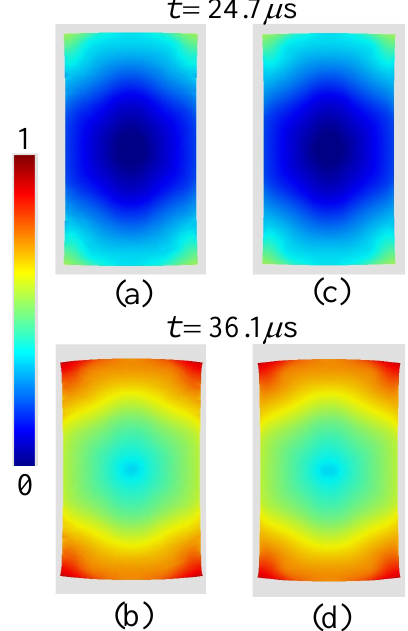
Figure 7. Damage responses at different times for two different meshes. Figures ( a , b ) correspond to the coarse mesh and figures ( c , d ) correspond to the medium mesh. The results are shown on the deformed mesh with a magnification factor of